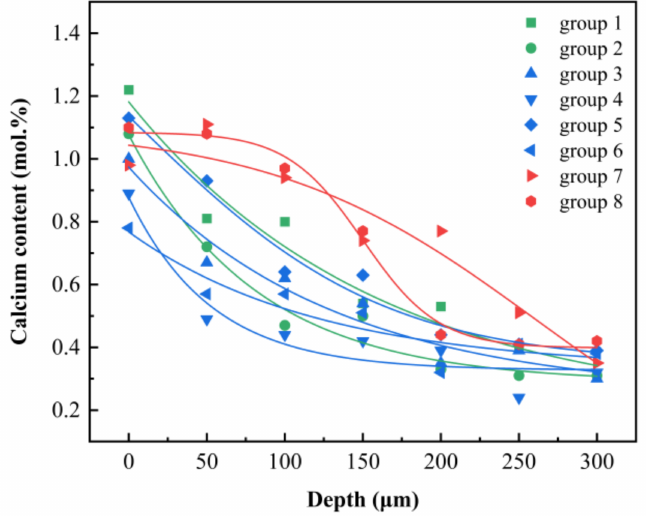
Figure 6. Variation curve of Ca content with depth after 600 s heat